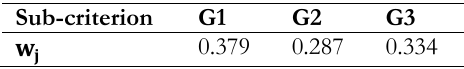
Table 15. The weight of the sub-criteria after